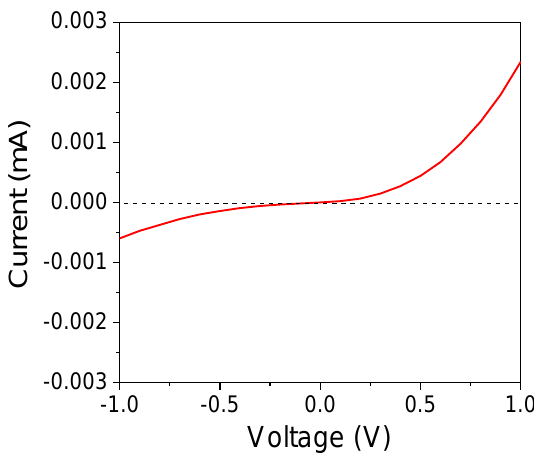
Figure 3. Current-voltage characteristic curve of TiO 2 -Ni junction.